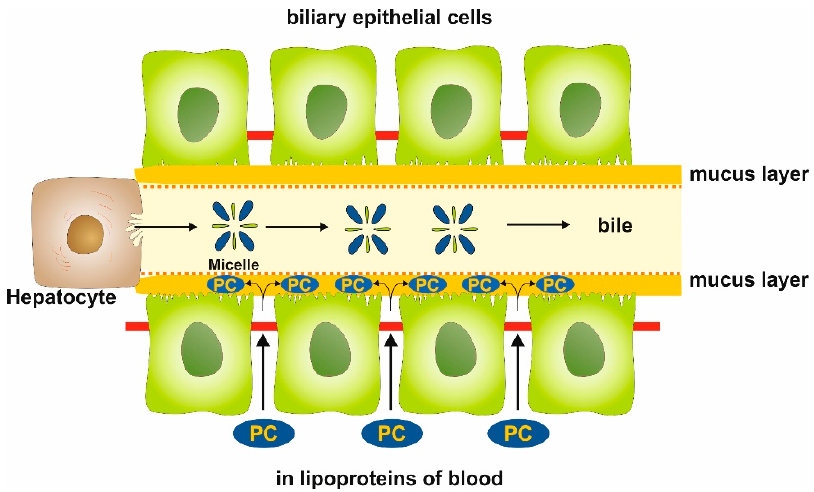
Figure 11. Scheme illustrating the paracellular transport of phosphatidylcholine (PC) across the tight junction barrier to the mucus layer at the apical side of biliary epithelium. The transport is driven by a negative electrical gradient with consequent binding to membrane-localized mucin 3 and an equilibrated shift to secretory mucin 2.